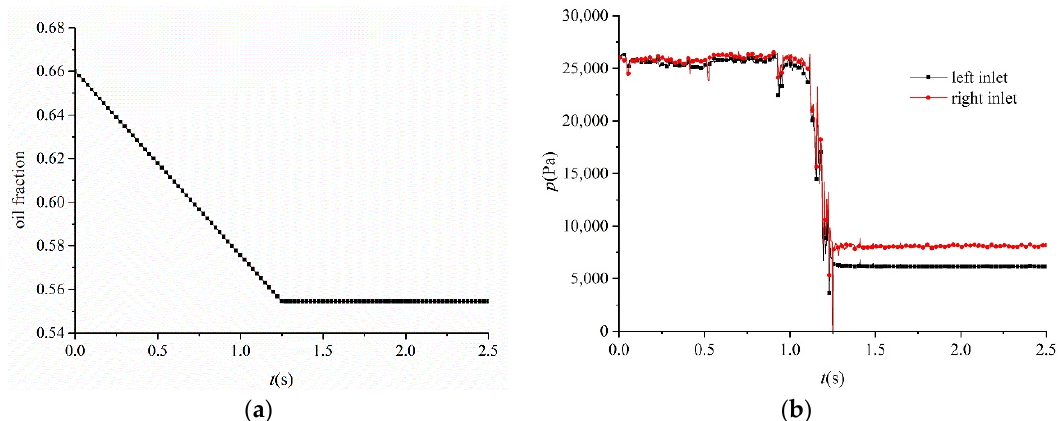
Figure 21. Variation of the inlet pressure and oil saturation with time: ( a ) oil saturation in the core sample with time; ( b ) pressure at the injection port with time.